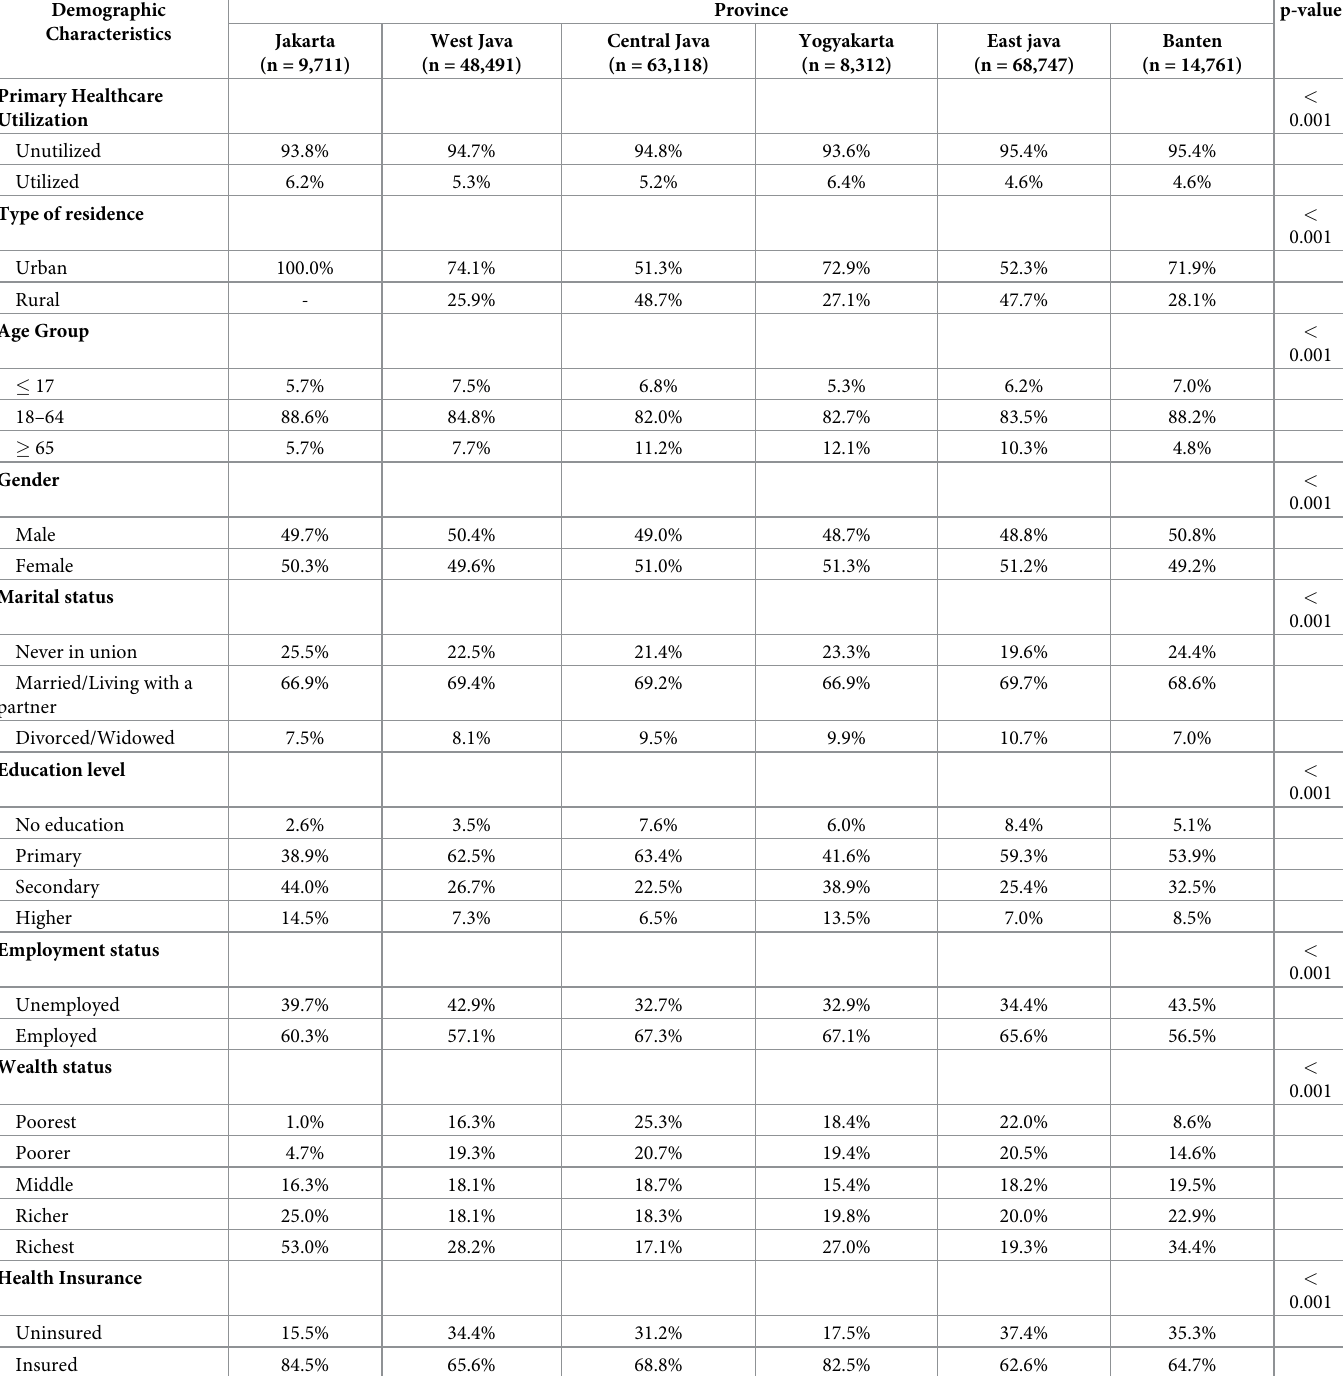
Table 1. Descriptive statistic of primary healthcare utilization and respondents’ characteristics in Java Region in Indonesia, 2018 (n = 213,140). Demographic